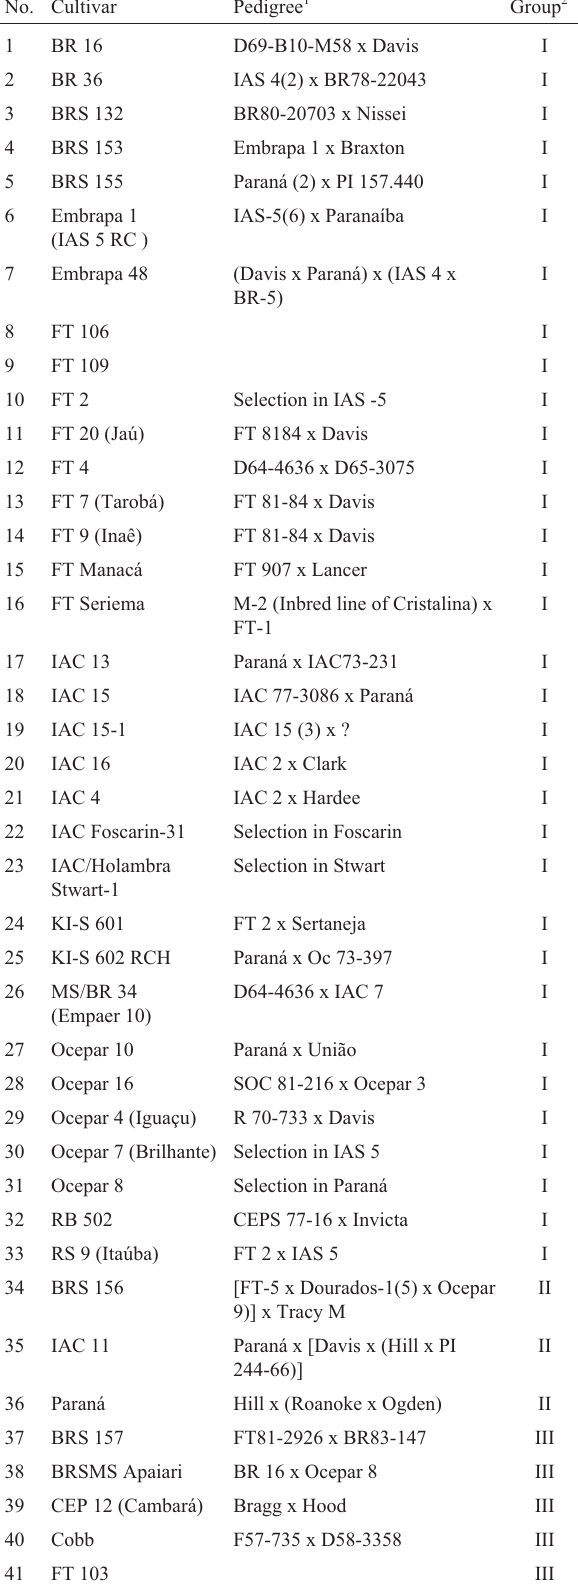
Table I - The soybean cultivars used in the present